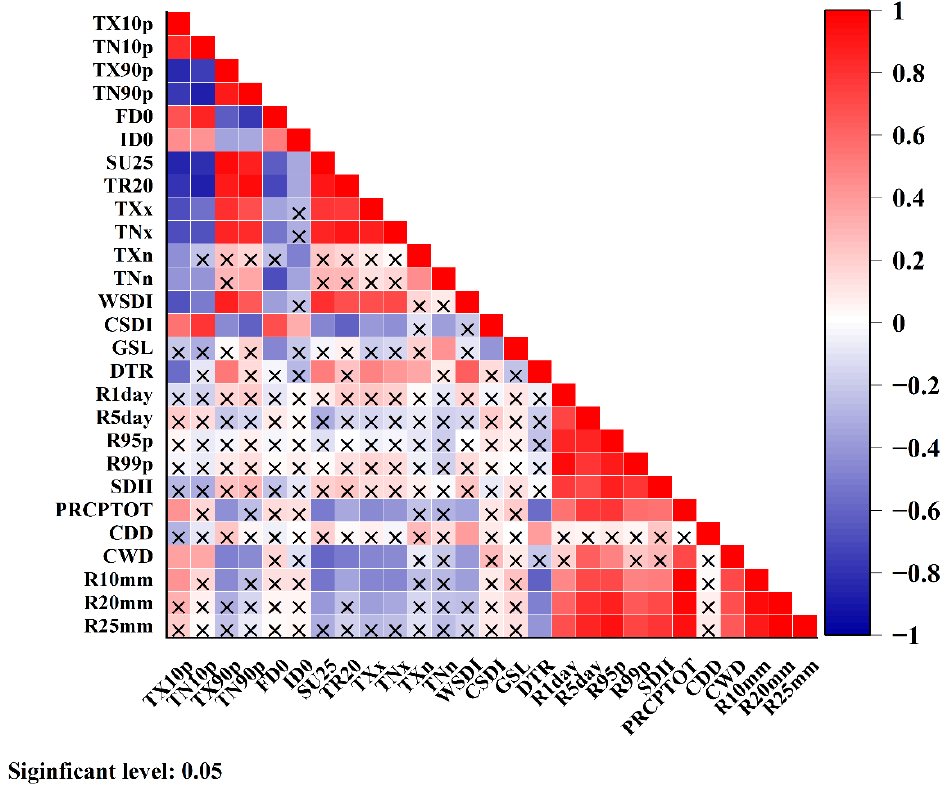
Figure 6. The cross-correlation indices of extreme climate indices. Notes: Red represents positive correlation, blue represents negative correlation. The darker the color, the greater the correlation coefficient. The “×” indicates that their correlation coefficient fails the significance test ( p < 0.05).